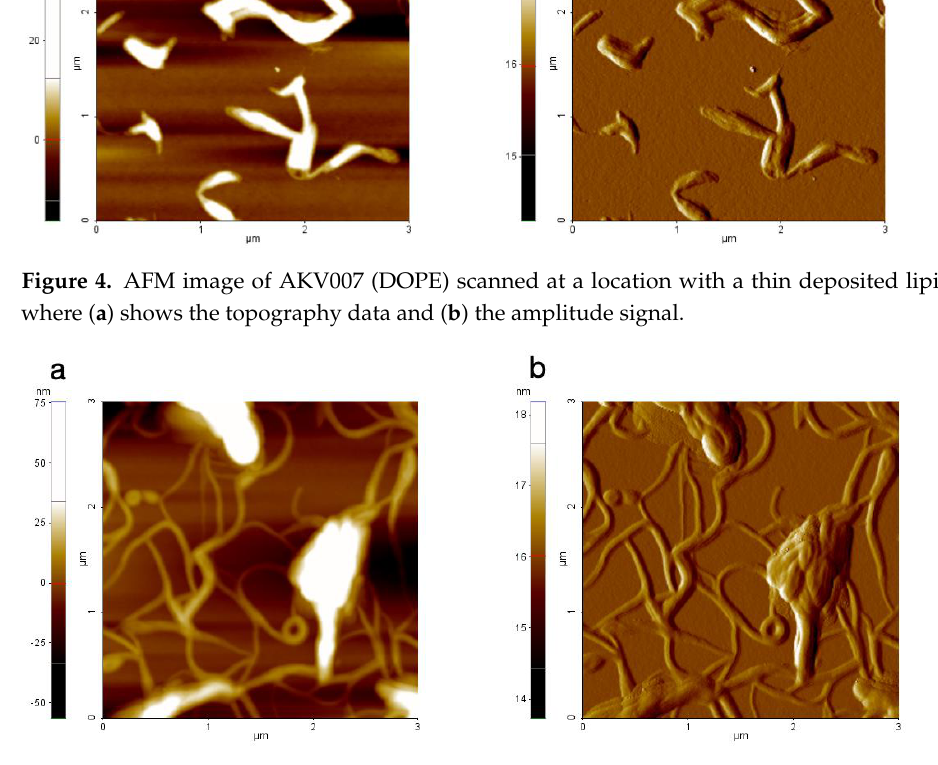
Figure 5. AFM image of AKV007 (DOPE) scanned at a location with “thicker” deposited lipid film, where ( a ) shows the topography data and ( b ) the amplitude signal.